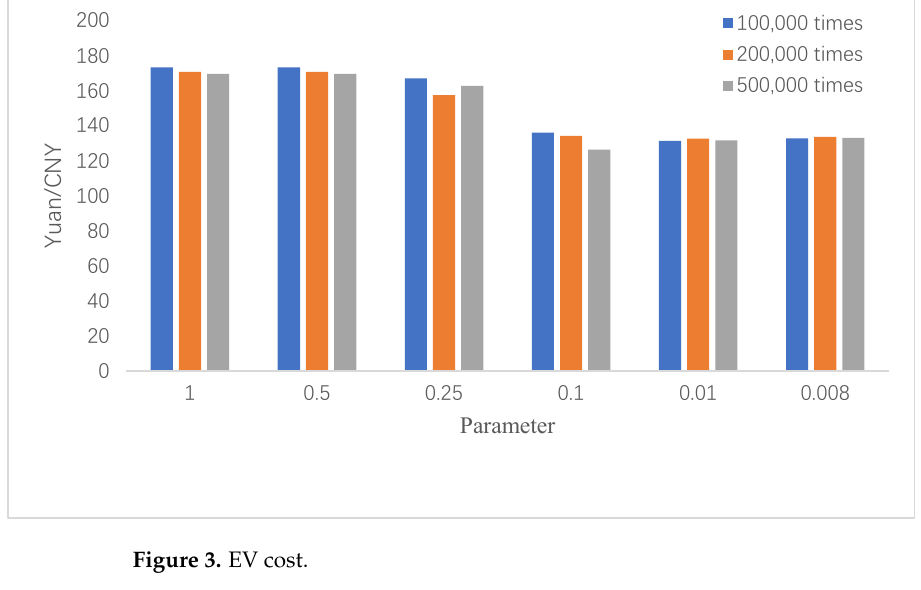
Figure 3. EV cost.